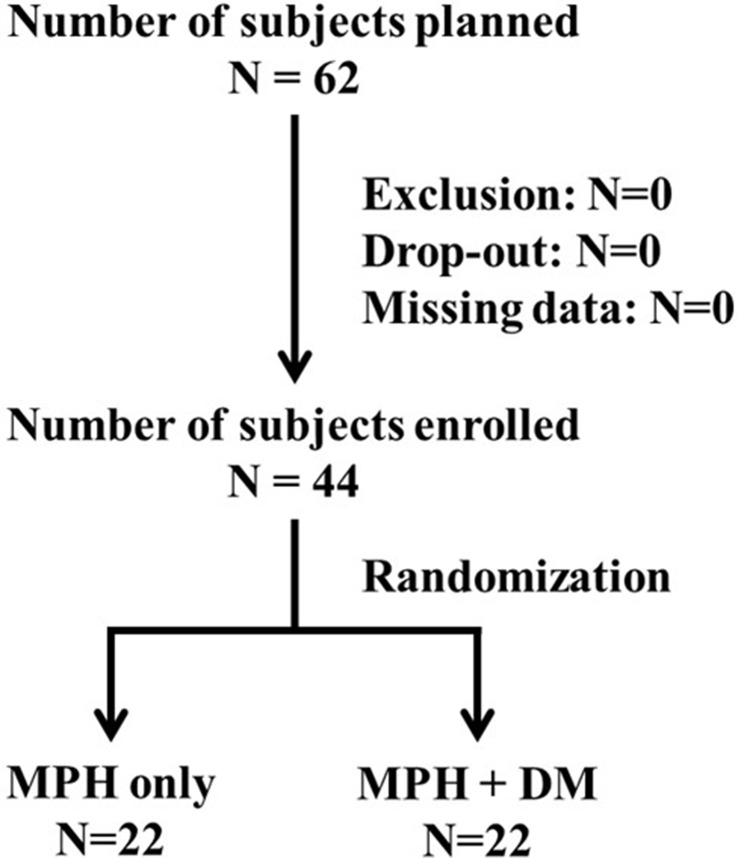
Flow Diagram of Participants.